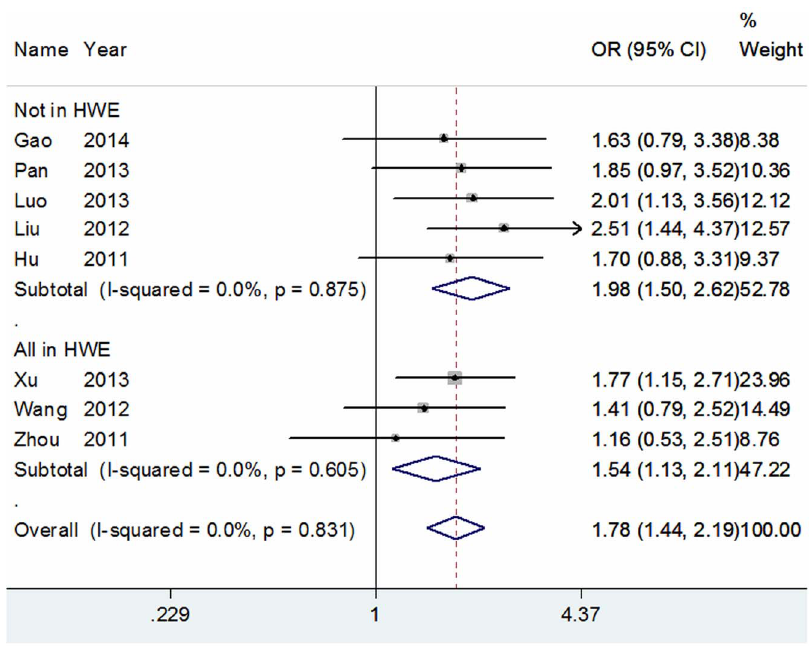
Figure 3. Forest plots of ORs with 95% CI for XRCC1 Arg194Trp polymorphism and the risk of glioma observed in recessive model among Chinese (fixed effects). The center of each square represents the OR, the area of the square is the number of sample and thus the weight used in the meta-analysis, and the horizontal line indicates the 95%CI.